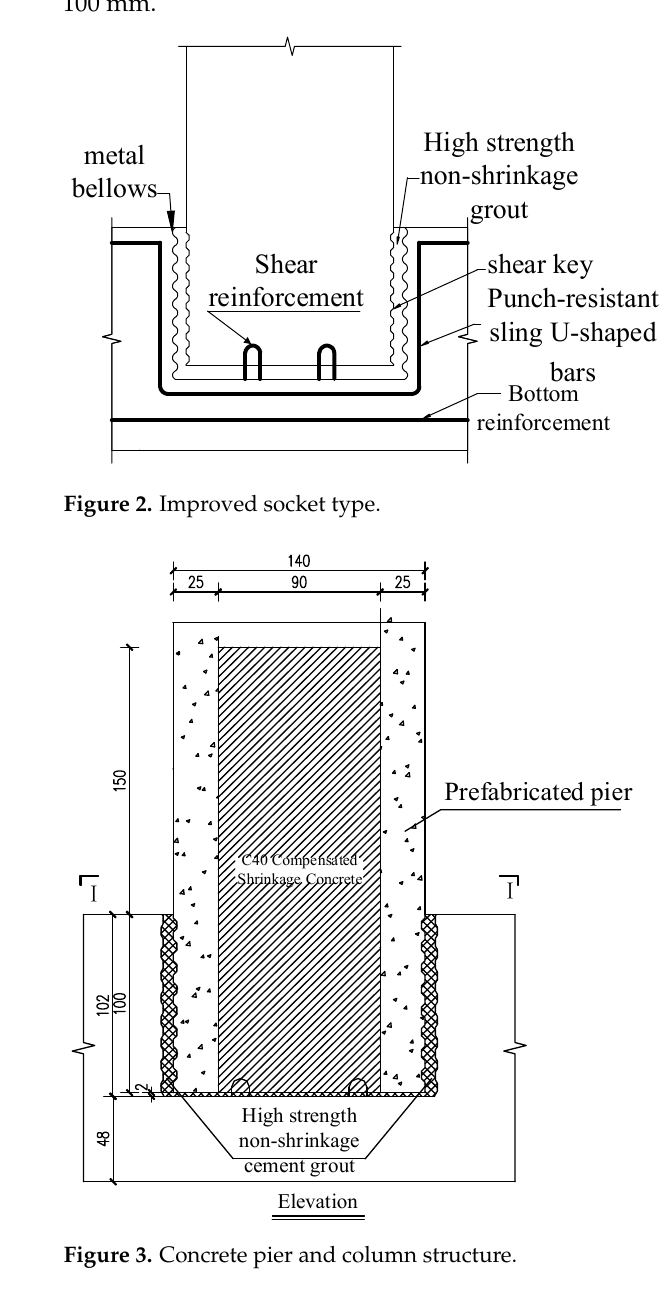
( b ) Figure 4. Reinforcement diagram of the full-scale bridge pier. ( a ) Pier section; ( b ) cap reinforce- ment. 2.3. Model Specimens During the experimental study, the similarity ratio was 1:2. The diameter of the steel bar of the model cap and the base plate of the cap was 18 mm; the diameter of the other bars was 12 mm, as shown in Figure 5. To meet the requirements of the length of the longitudinal reinforcement, the bottom of the pier was provided with a perforated plug welding of the steel plate with the longitudinal reinforcement of the pier. 18mm 12mmPunch-resistant sling U-shaped bars Bottom reinforcement Figure 5. Diameter distribution diagram of the bottom. The specimens were poured with C70 concrete and filled with C40 concrete. The longitudinal steel bars were HRB400 steel bars, where 18 steel bars had a diameter of 20 mm in the outer ring and 9 steel bars had a diameter of 10 mm in the inner ring, and HPB300 spiral stirrups had a spacing of 100 mm. The main reinforcement of the pier column and the steel end plate adopts perforated plug welding, the size of the steel end plate was the same as the section of the pier column, the thickness was 10 mm, and Q235 (Q235 indicates a steel plate with a yield strength of 235 MPa) steel was used. The struc- ture diagram of the scaled pier column is shown in Figure 6.